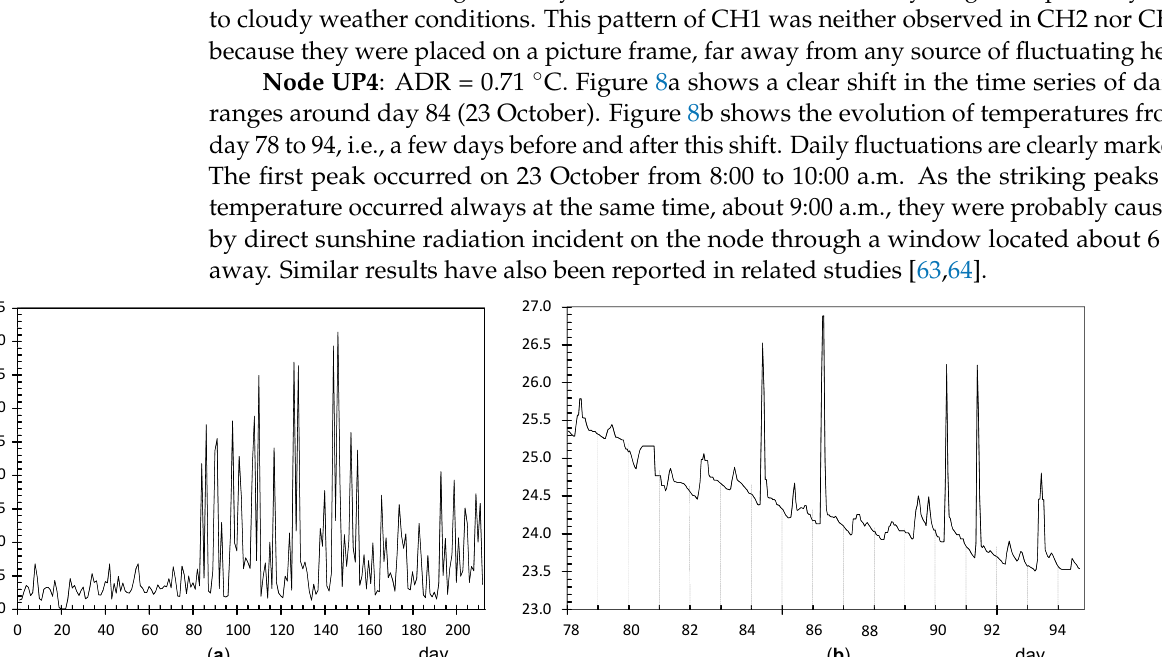
Figure 8. Node UP4: ( a ) time series of daily ranges of temperature ( ° C) for the whole period of 212 days, ( b ) time series of hourly values of temperature from day 78 (17 October 2017) until day 94. Node LO3 : ADR = 0.64 ° C. The evolution of daily ranges over time (Figure 9a) reveals